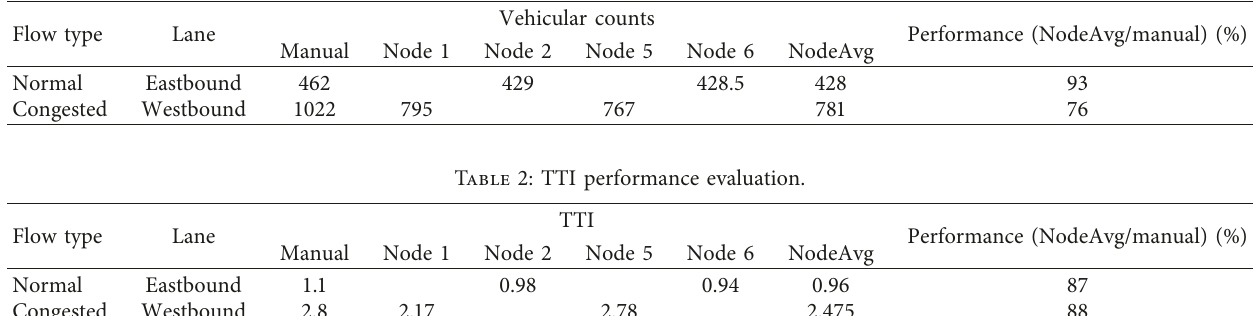
Figure 12: Simulation results were two sensors nodes (2 and 6) were used to monitor normal traffic flow on westbound lanes: (a) cumulative vehicular count; (b) Travel Time Index (TTI). Table 1: Vehicular counts performance evaluation.